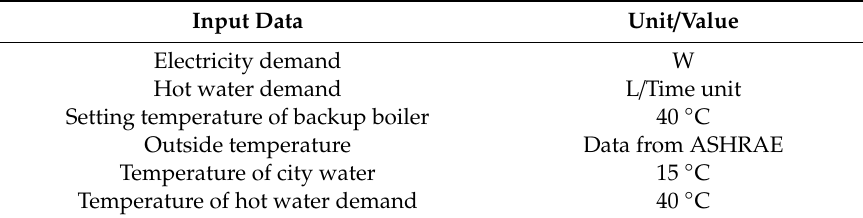
Figure 6. Calculation diagram of the program. Table 7. Input data of the program.